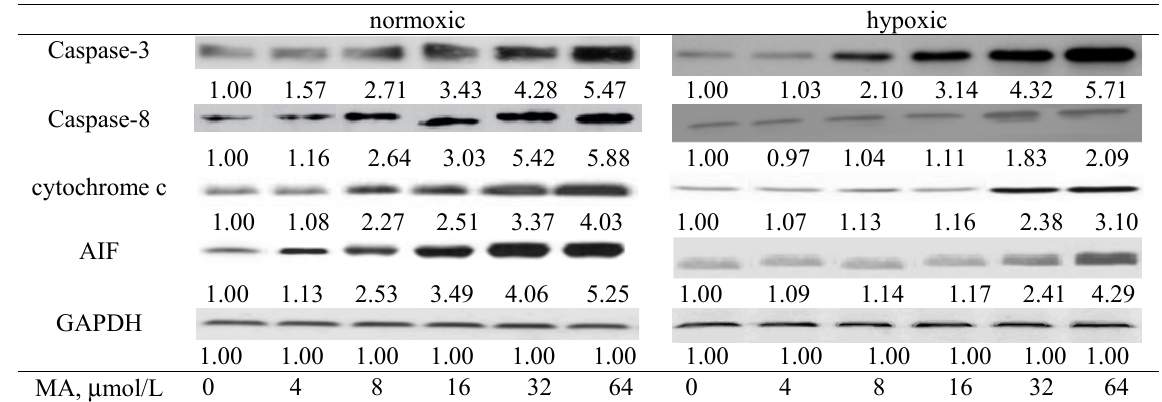
Figure 5. Effects of MA at 0, 4, 8, 16, 32 or 64 μ mol/L upon caspase-3, caspase-8, cytosolic cytochrome c and AIF expression in A549 cells under normoxic and hypoxic conditions. Data are mean ± SD ( n =